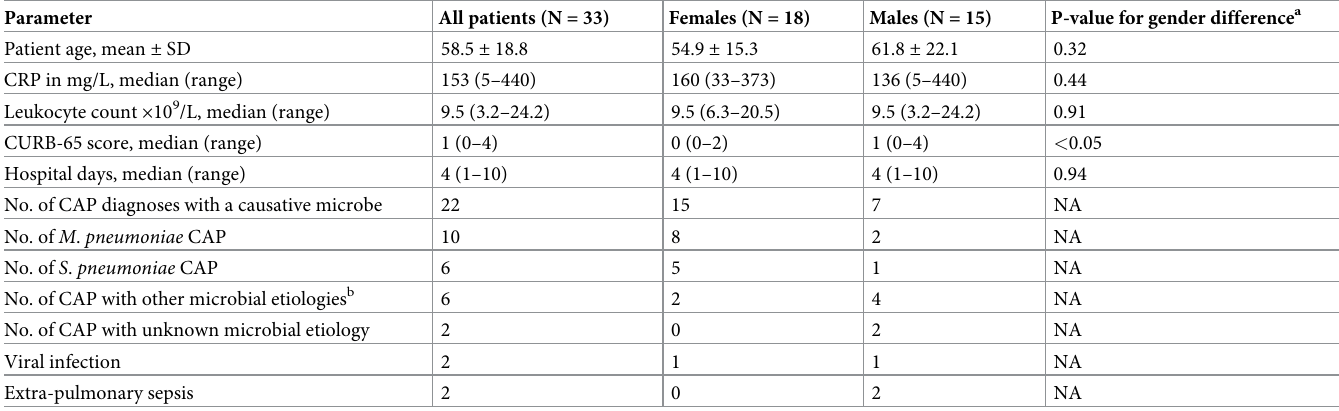
Table 1. Descriptive clinical and laboratory